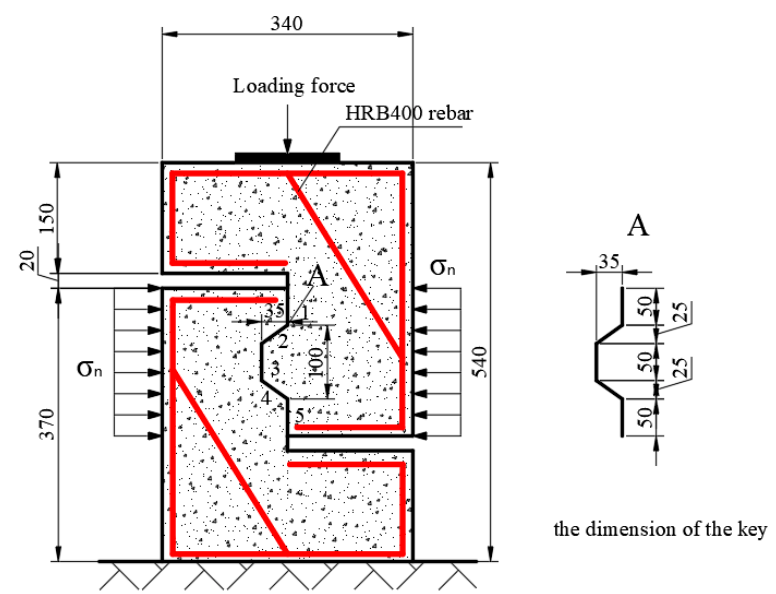
Figure 1. Dimensions and configurations of the specimen (unit: mm).